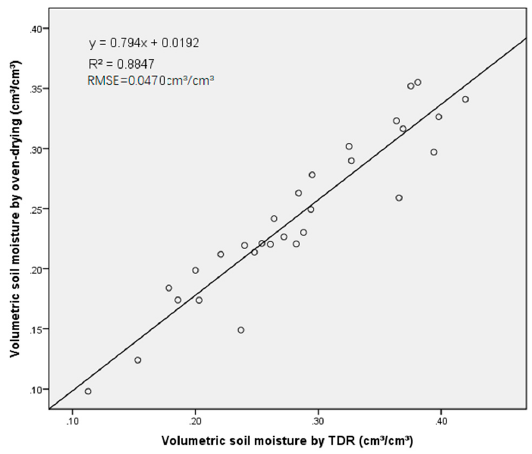
Figure 3. Calibration of volumetric soil moisture acquired by TDR probes.